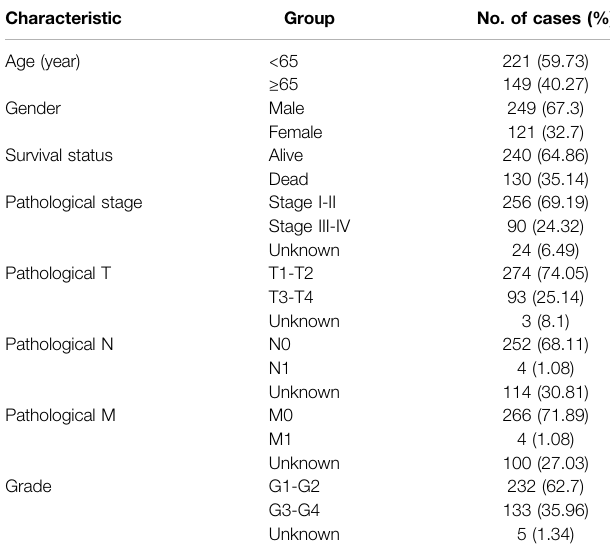
TABLE 1 | Clinical pathological features of HCC patients ( n = 370) from TCGA